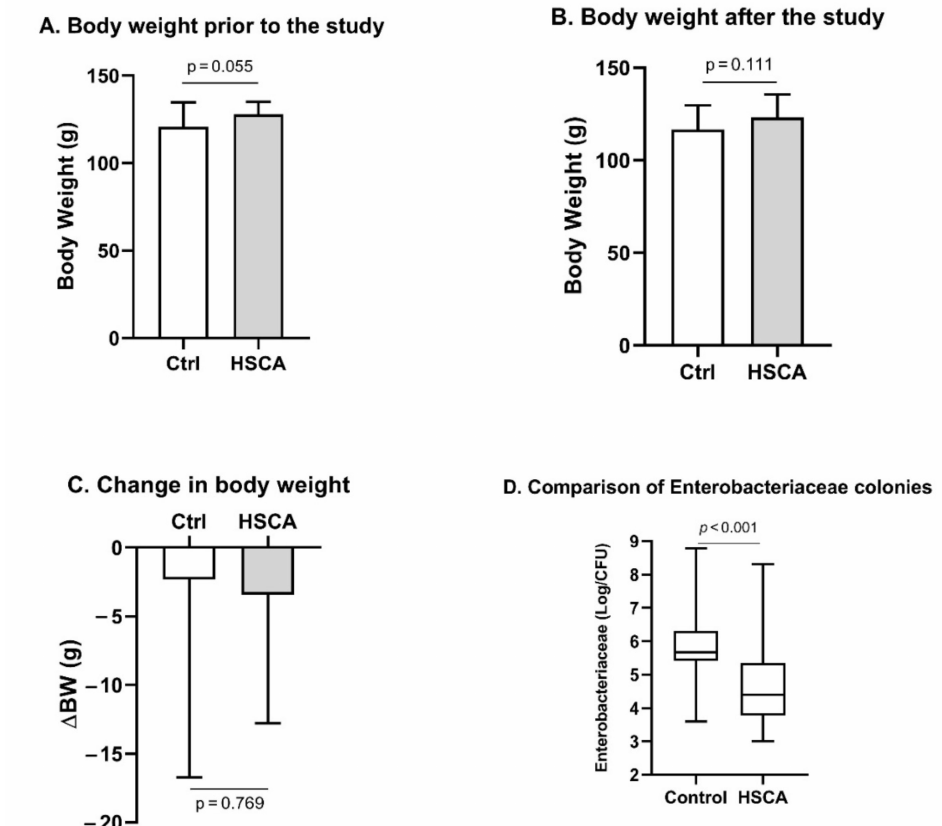
Figure 1. HSCA did not affect body weight but reduced Enterobacteriaceae composition in female rats. Rat body weight showed no difference between the two groups before and after the study ( A , B ). Body weight seemed reduced, but there was no significant difference between both groups ( C ). Enterobacteriaceae in HSCA rats was significantly lower than that in control rats (in CFU) ( D ). ( A – C ) Mean ± SD (Student’s t -test). ( D ) Median, with minimum and maximum values (Mann– Whitney U test). HSCA, high sucrose and cholic acid; ∆ BW, the difference between body weight before and after the study; CFU, colony-forming